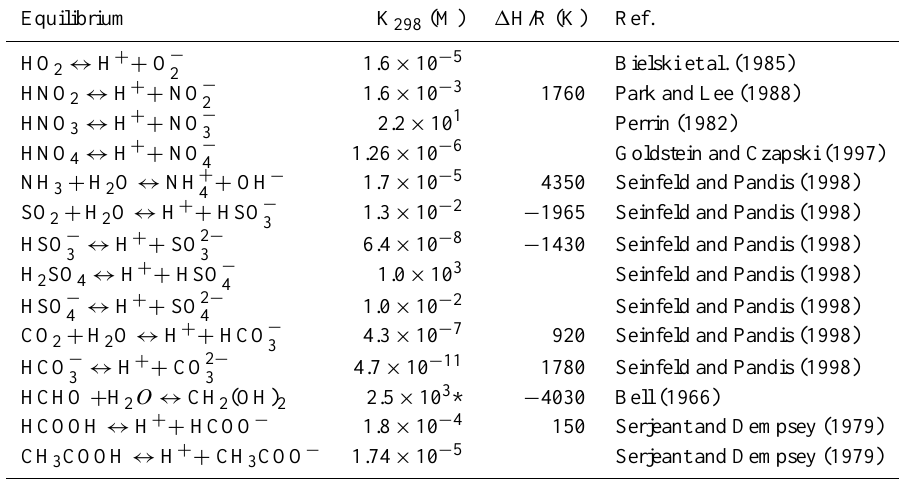
Table 2. Aqueous phase equilibria at 298 K (K 298 ) and associated temperature dependencies ( 1 H/R). Equilibrium K 298 (M) 1 H/R (K)